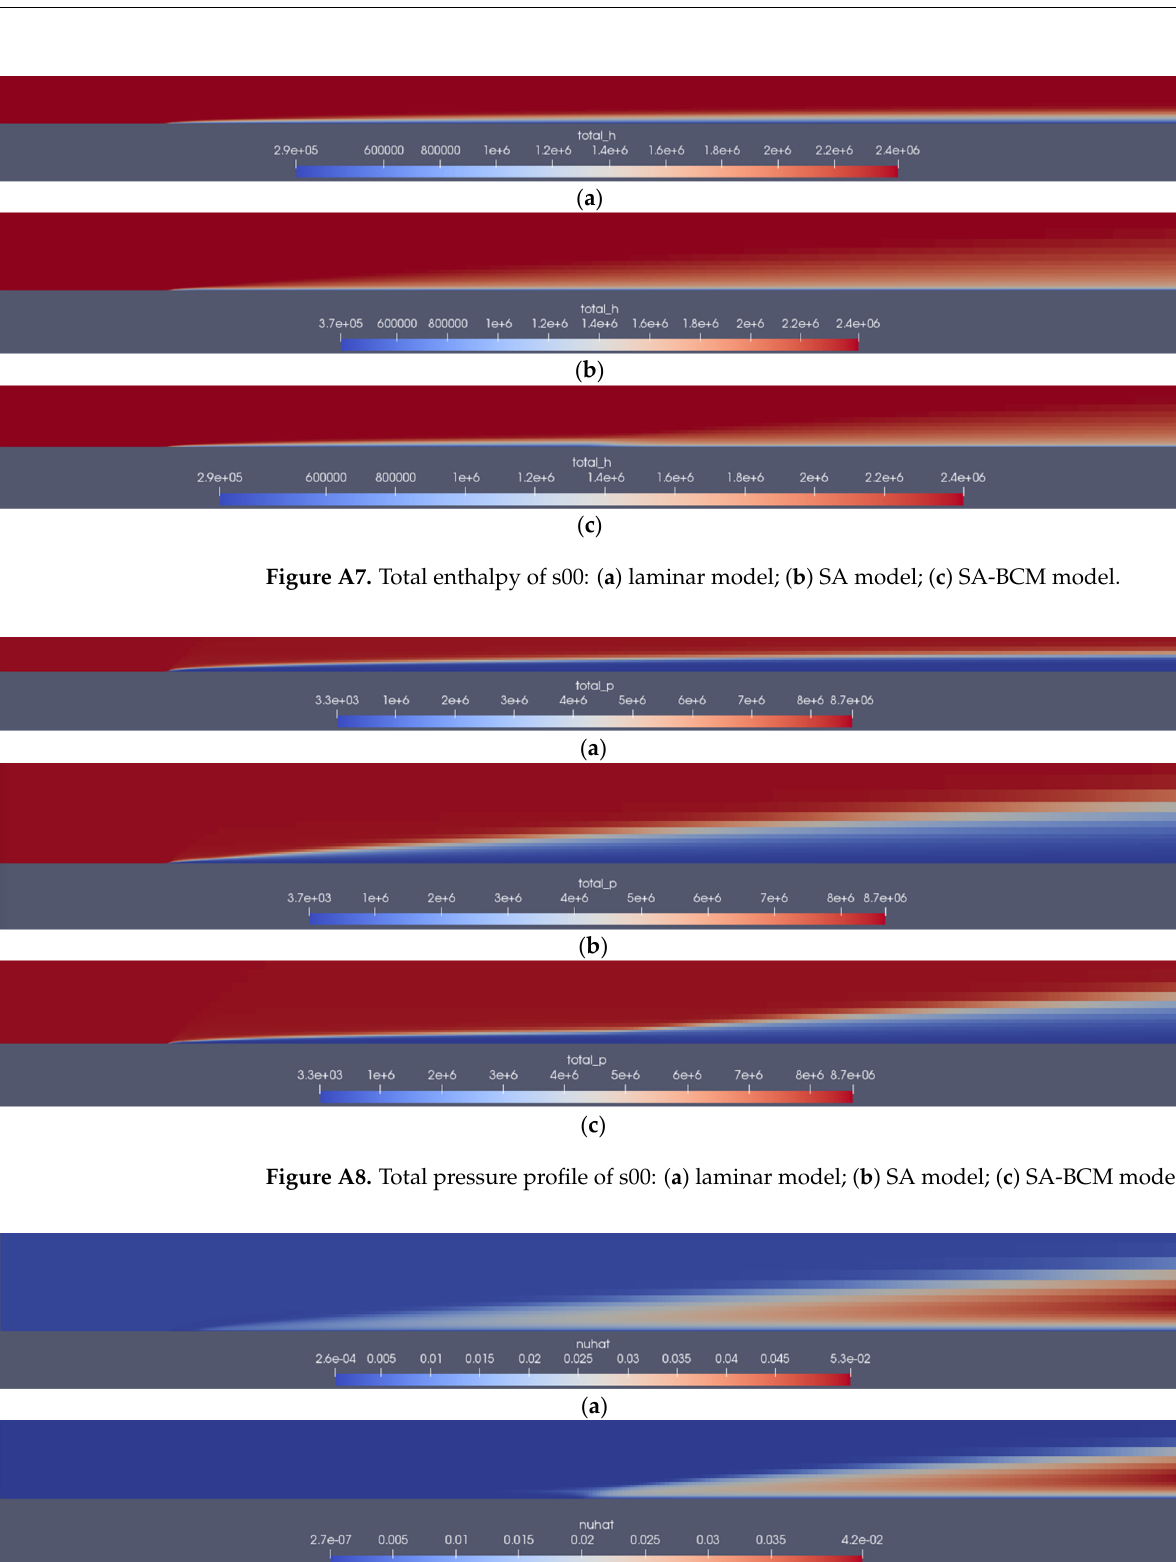
Figure A9. Nuhat profile of s00: ( a ) SA model; ( b ) SA-BCM model.